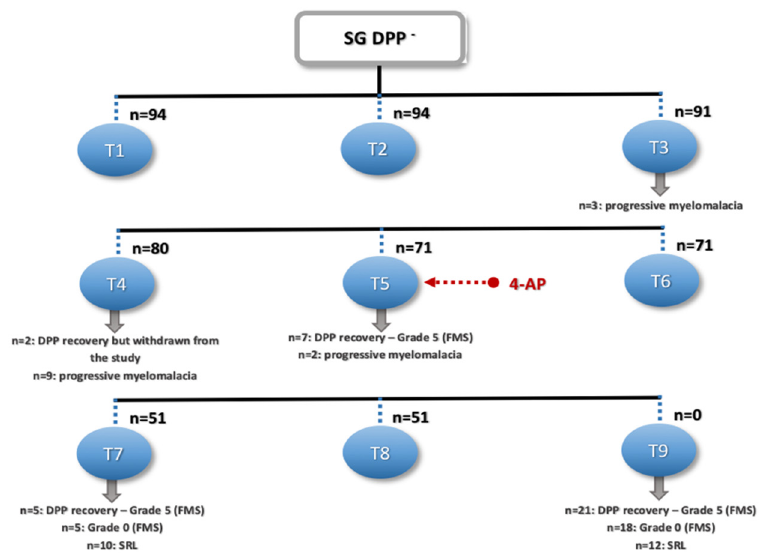
Figure 8. Flow diagram describing the results of the DPP − dogs in the study group. SG: study group, DPP − : deep pain perception-negative, T1: admission, T2: day 3, T3: day 7, T4: day 15, T5: day 30, T6: day 45, T7: day 60, T8: day 75, T9: day 90, FMS: Frankel modified scale, and SRL: spinal reflex